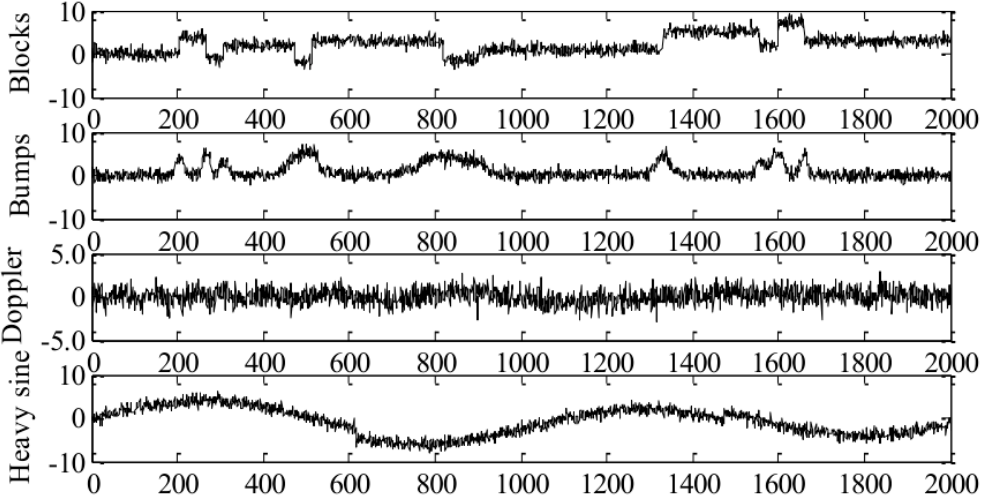
Figure 3. Waveforms of the simulation signals containing noise.